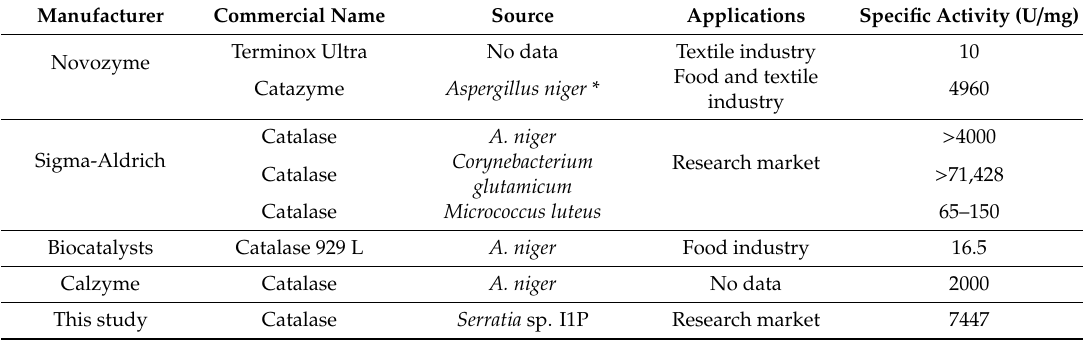
Table 4. Commercially available catalases and their uses.